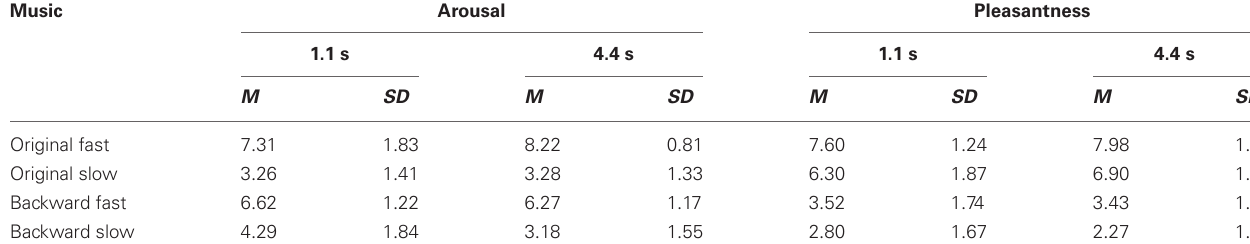
Table 1 | Mean and standard deviation of ratings of arousal and pleasantness (9-point scale) for musical excerpts presented in their original and backward version with a fast and a slow tempo for a 1.1 and a 4.4-s duration.